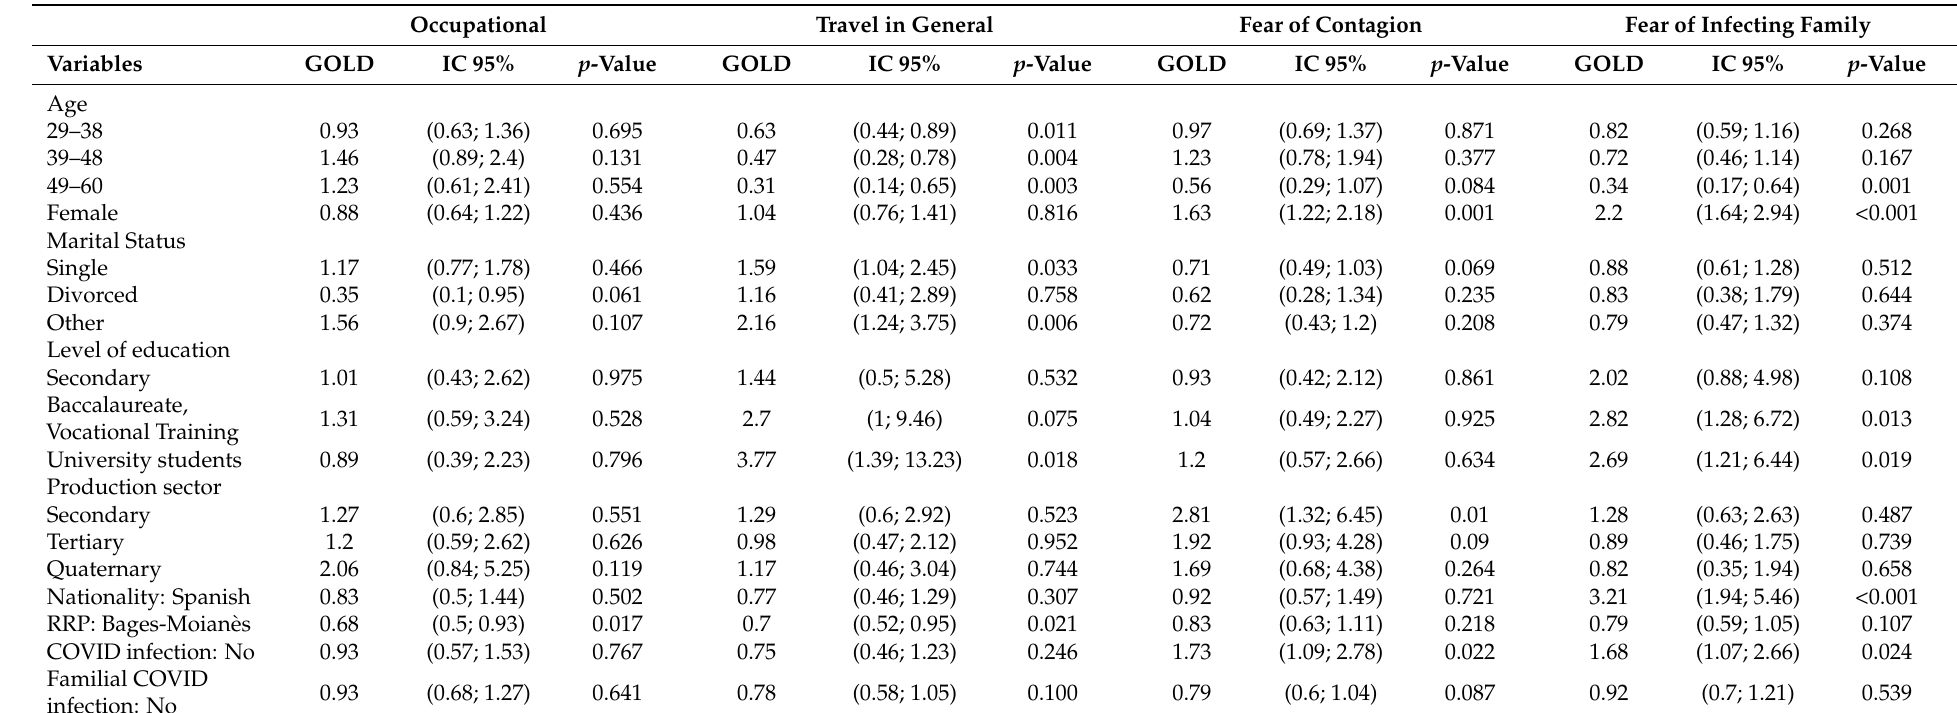
Table 3. Logistic